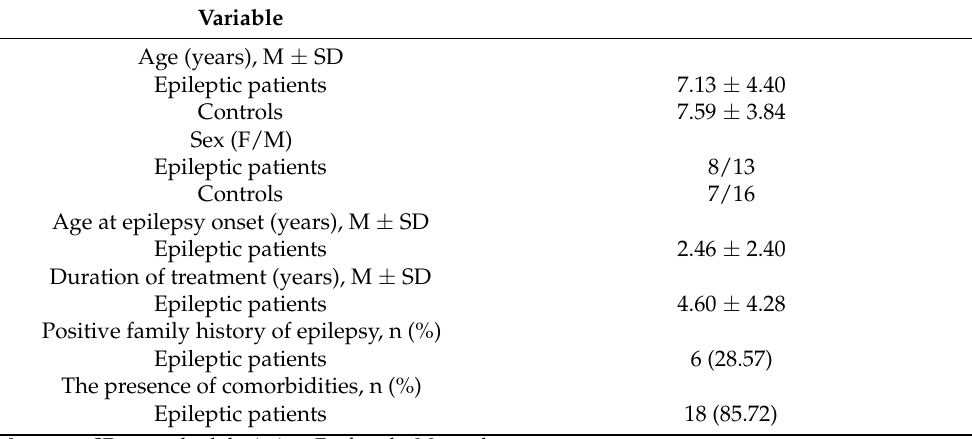
Table 2. Demographic and clinical characteristics of the analyzed groups of